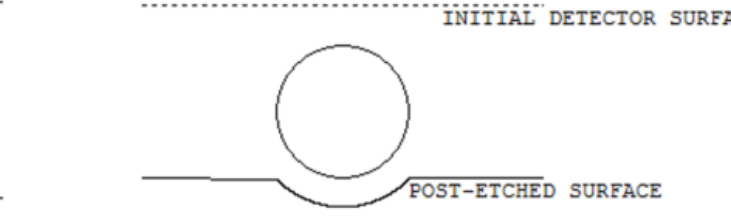
Figure 3. The diameter given by the revised TRACK_VISION program was 23.2 µ m, and the two values were deemed to have good agreement.